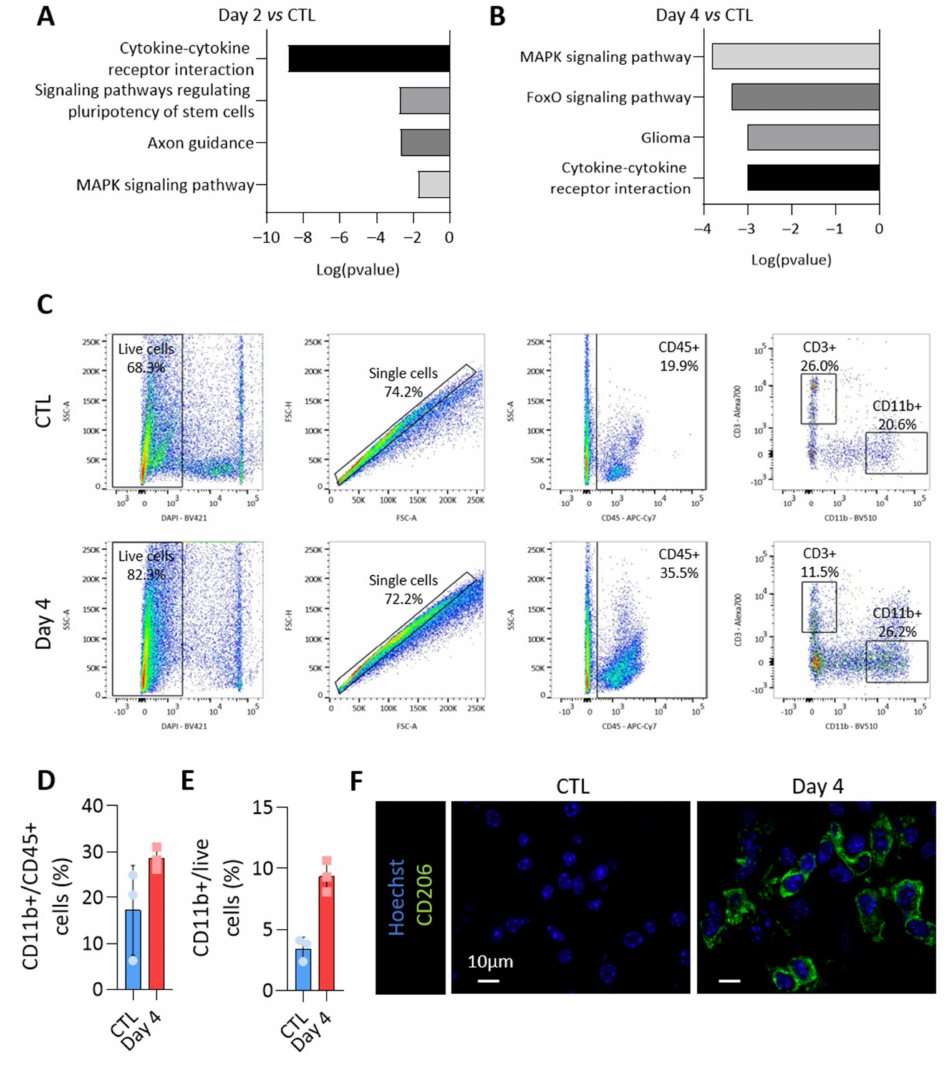
Figure 6. The loading of the upregulated miRNAs in EVs could impact on the immune microen- vironment of the BRAF V600E tumor. The KEGG pathway analysis using the most abundant EV- miRNAs ( A ) after 2 days and ( B ) after 4 days of BRAF V600E induction, as compared to control EV-miRNAs. ( C ) Flow cytometry analyses of CD45+, CD11b+ and CD3+ immune cells from dissoci- ated control and DOX-treated tissues (day 4). ( D , E ) Percentage of CD11b+ myeloid cells among the CD45+ immune population ( D ) or among the live cells ( E ). ( F ) Immunohistofluorescence of CD206 on thyroid tissues from the control and DOX-treated mice (day 4). DAPI (blue) is used to label the